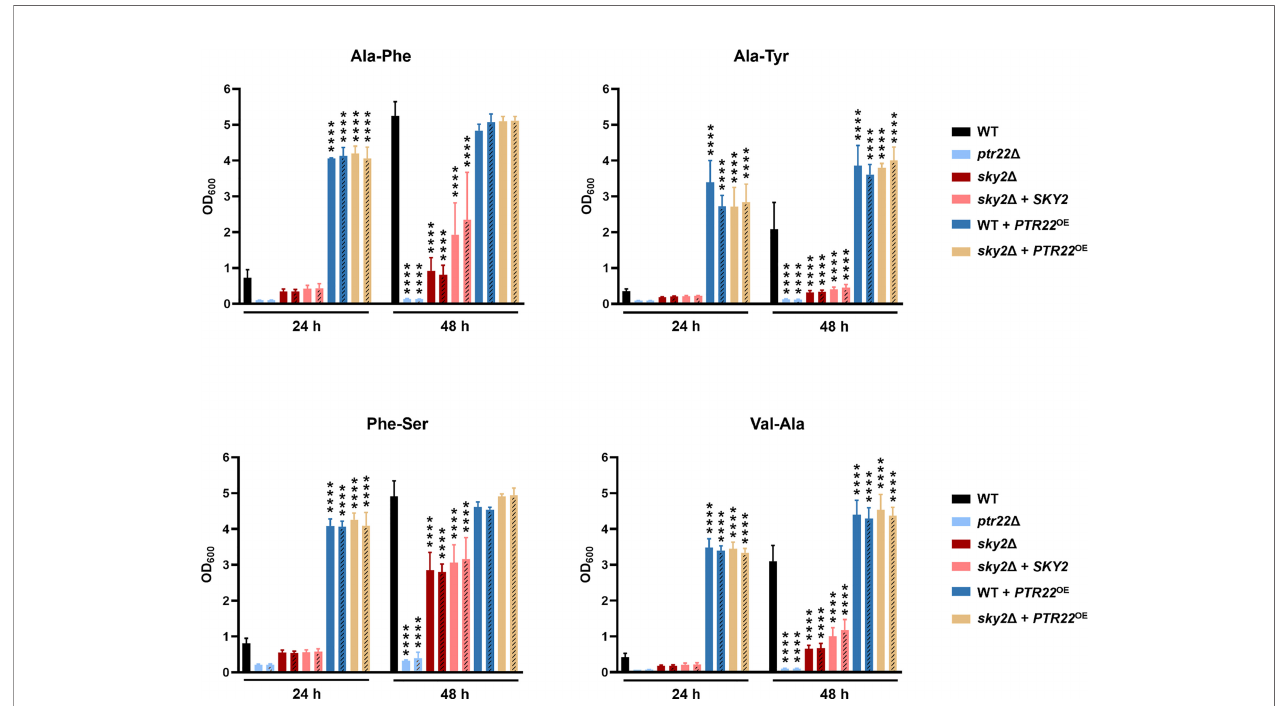
FIGURE 8 | PTR22 overexpression rescues the Ca sky2 D mutant phenotype. YPD overnight cultures were adjusted to an optical density (OD 600 ) of 0.01 in YCB medium containing 10 mMofthe indicated dipeptide as a nitrogen source andincubated at 37°C. The OD 600 was measured after 24 h and 48 h.The values shownare the calculated mean andstandard deviation ofthree biological replicates. The independentlygeneratedB strains of each mutant are represented bydashes in the bars. Growth differences of mutant strainsto the wild-type strain SC5314 were analyzed by two-way ANOVA followed byDunnett ’ s test (*, p < 0.05; **,p < 0.01; ****,p < 0.0001). Data for the wild type, sky2 D mutants, and SKY2 complementedstrains are the same as in Figure 4 , since allstrains shown inthe two fi gures were tested in